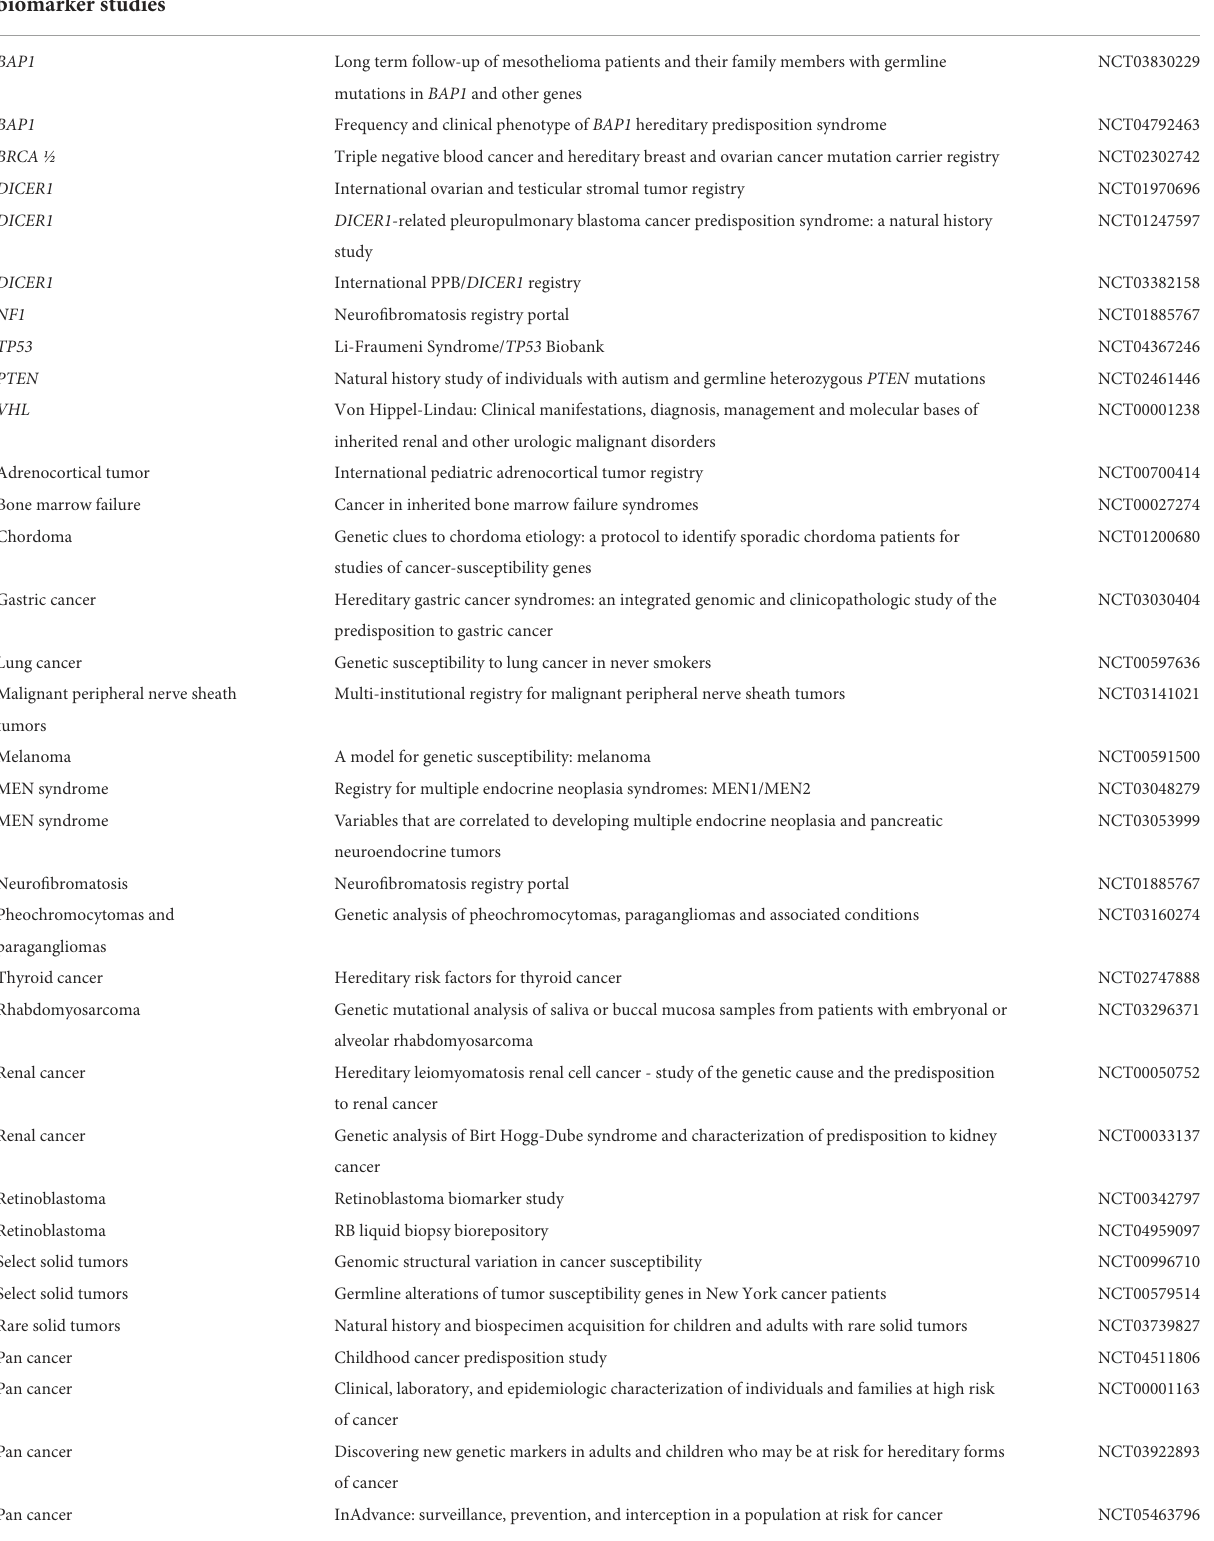
TABLE 7 Germline cancer registries and biobanks enrolling pediatric patients in the United